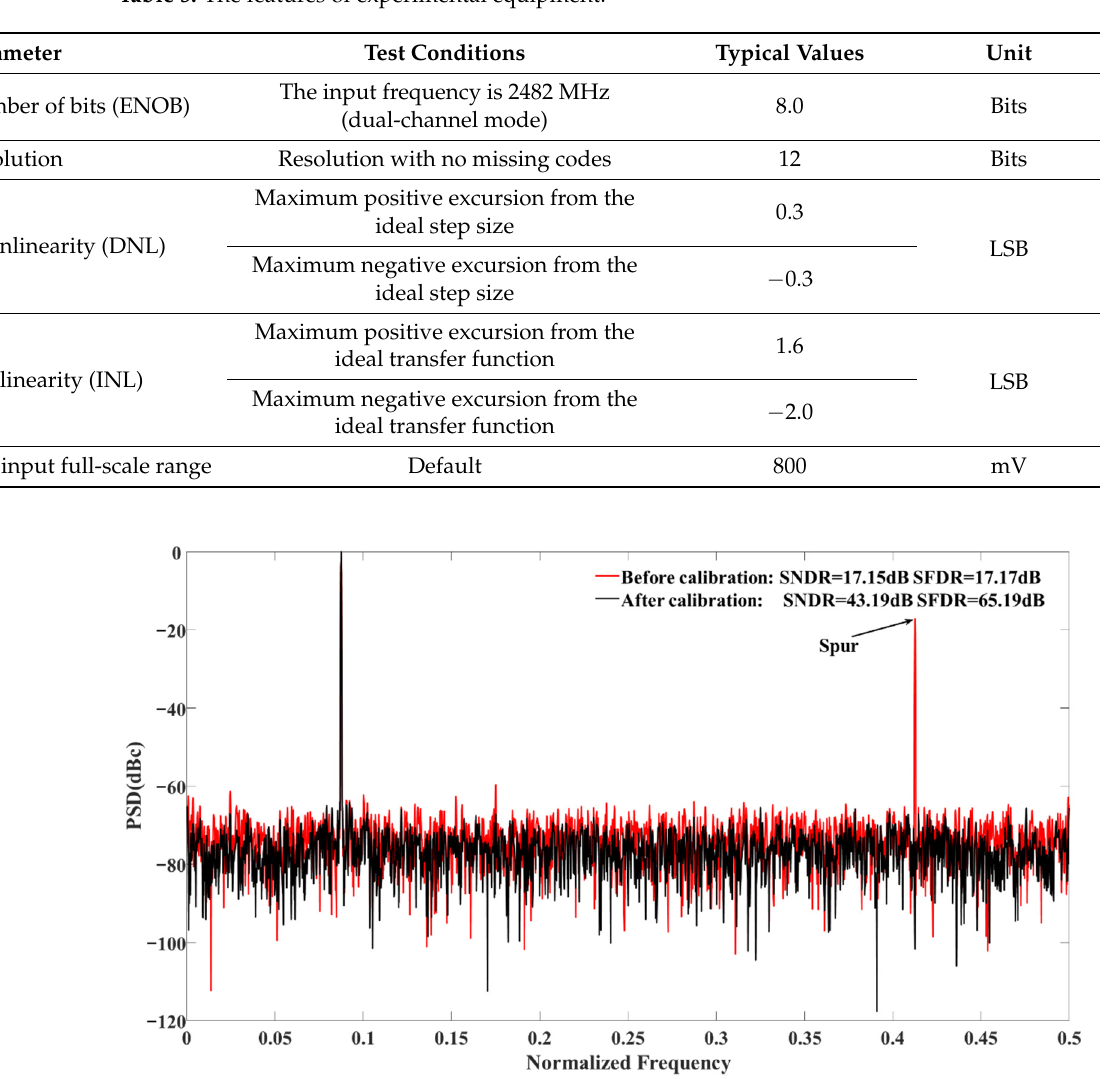
Figure 16. The frequency spectrum of the commercial 2-channel TI-ADCs before and after calibra ‐ tion.